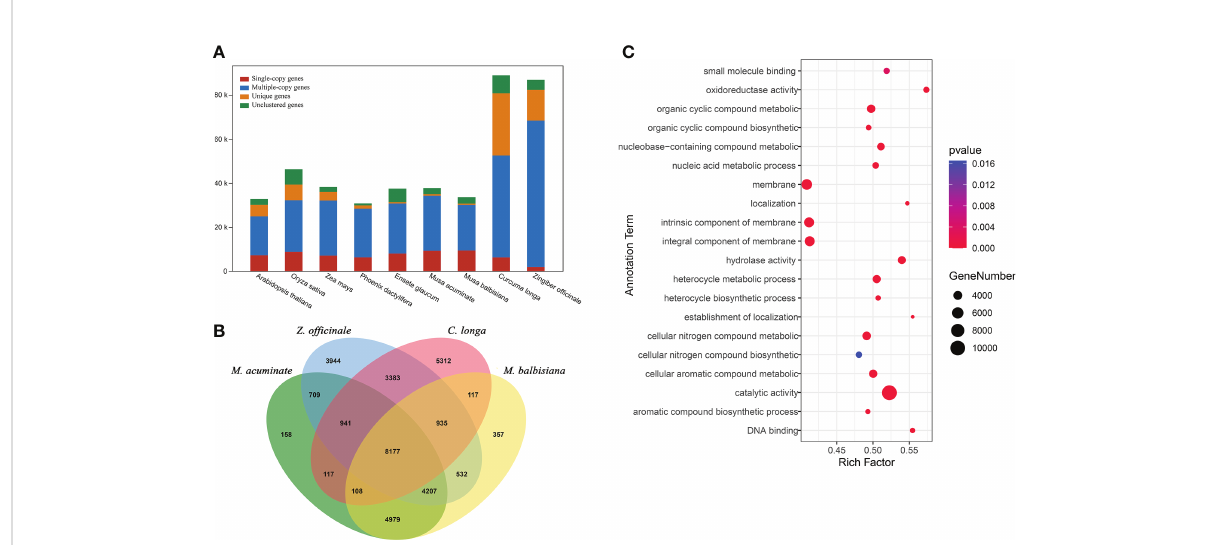
FIGURE 3 Comparative genomic analysis of C. longa . (A) Orthologous genes found in different plant species. (B) Venn diagram of the number of shared gene families within C. longa , Z. of fi cinale , M. balbisiana and M. acuminate . The number in the Venn diagram is the number of gene families. (C) GO enrichment analysis of gene families speci fi c to